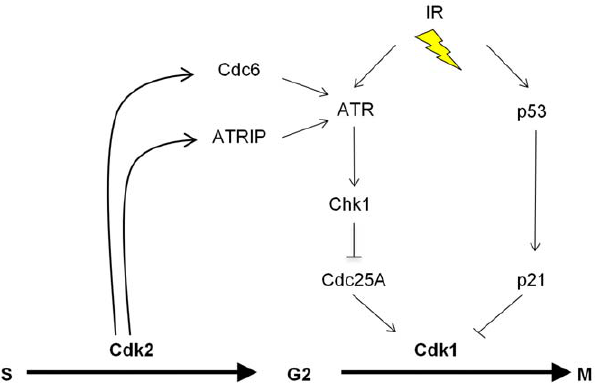
Figure 7. The proposed role of Cdk2 in the p53-independent regulation of Cdk1. Cdk2 directly phosphorylates at least two proteins, ATRIP and Cdc6, that directly regulate the G 2 -M transition via the ATR-Chk1-Cdc25A pathway. The activity of Cdk1 is independently inhibited upon activation of the p53-p21 pathway, which is defective in many cancer cells. See text for additional